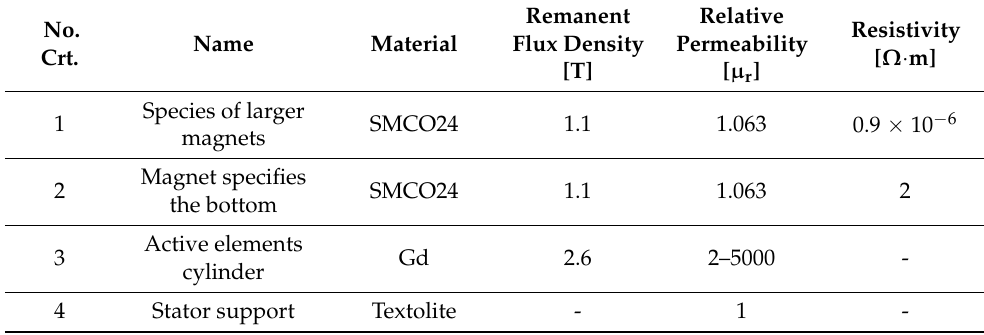
Table 3. Properties of materials used in modeling [25].